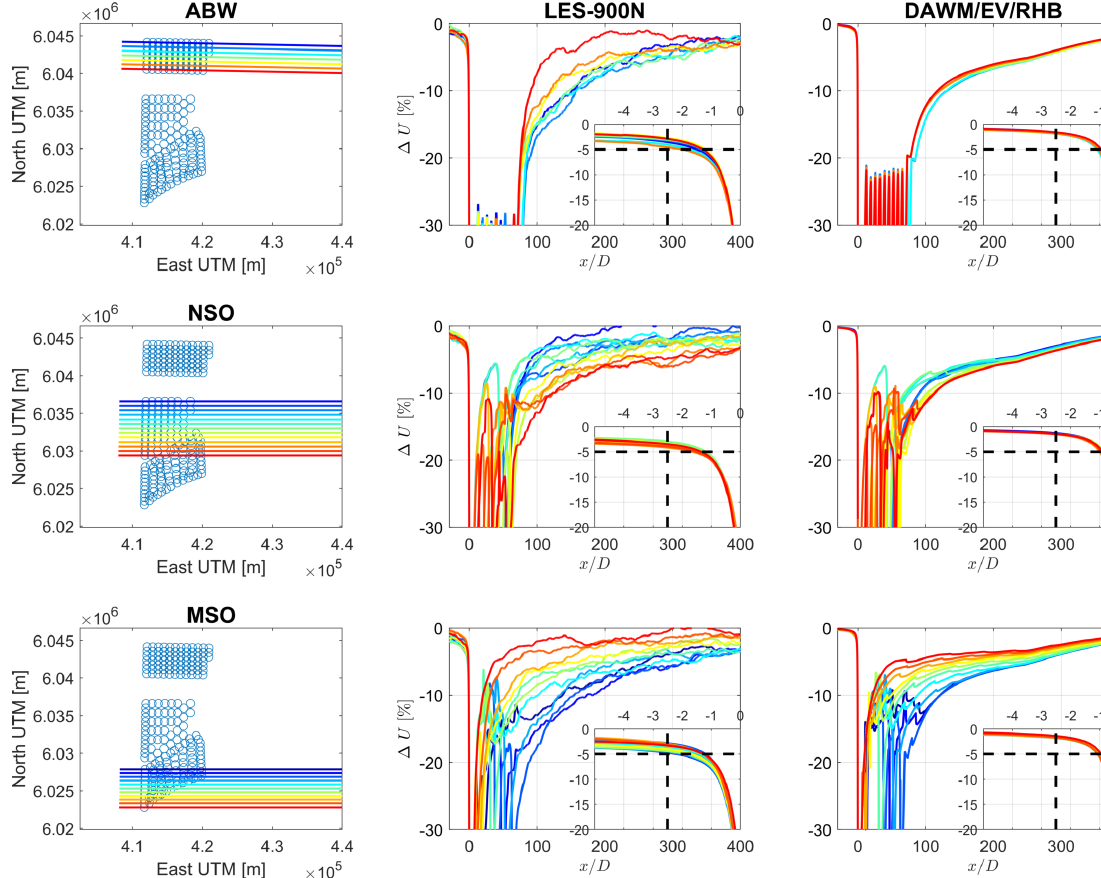
Figure 7. The percentage wind speed reduction as a function of distance from the front row turbine corresponding to the wakes and upstream (insets) of the ABW ( top ), NSO ( middle row ) and MSO ( bottom ) wind farms according to the LES-900N results (columns 1, 3) and the OpenWind DAWM/EV/RHB results (column 2, 4). The first column of panels illustrates the positions to which the curves in the other panels pertain based on the line coloring. For example, the blue curves in the top row pertain to the wind speed reduction along a line through the uppermost row of the ABW wind farm. The insets show those same lines but up to 5 D upstream of the first wind turbine. Note the change in vertical and horizontal scales for the right-hand